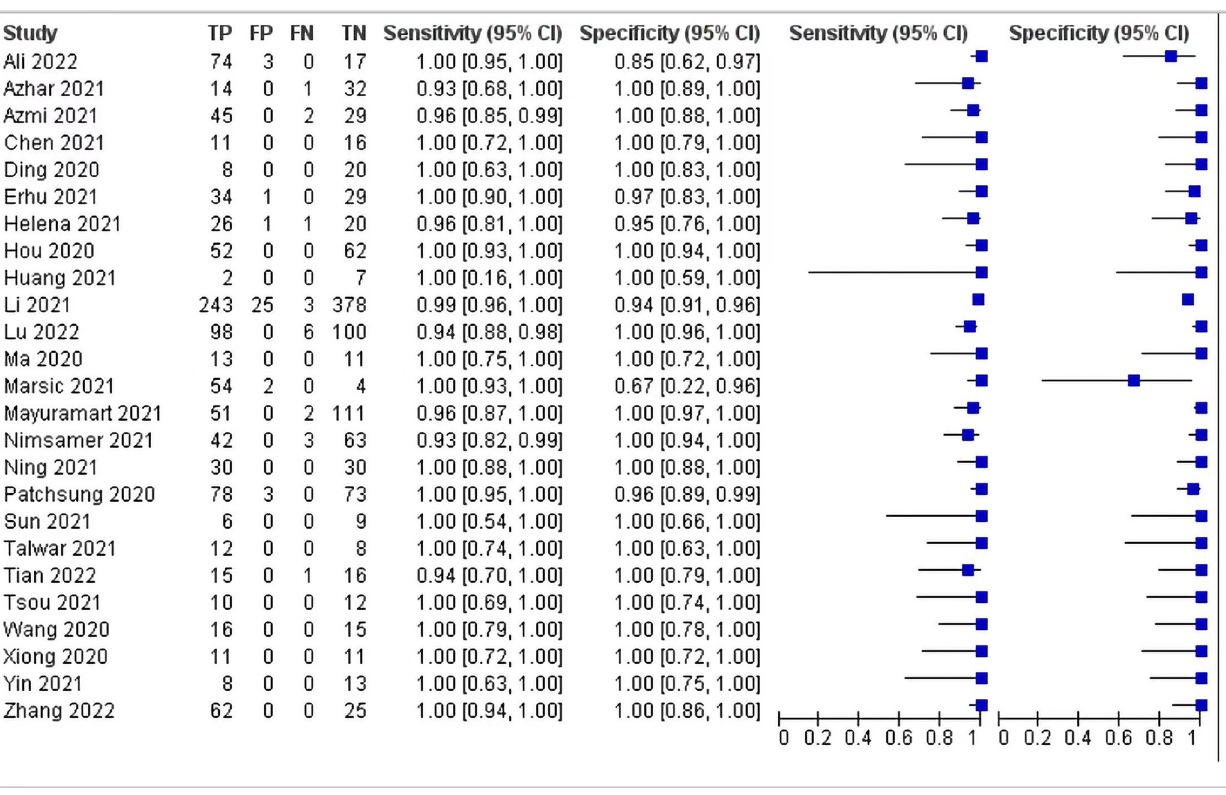
Fig 2. Forest plots of pooled sensitivity and specificity.